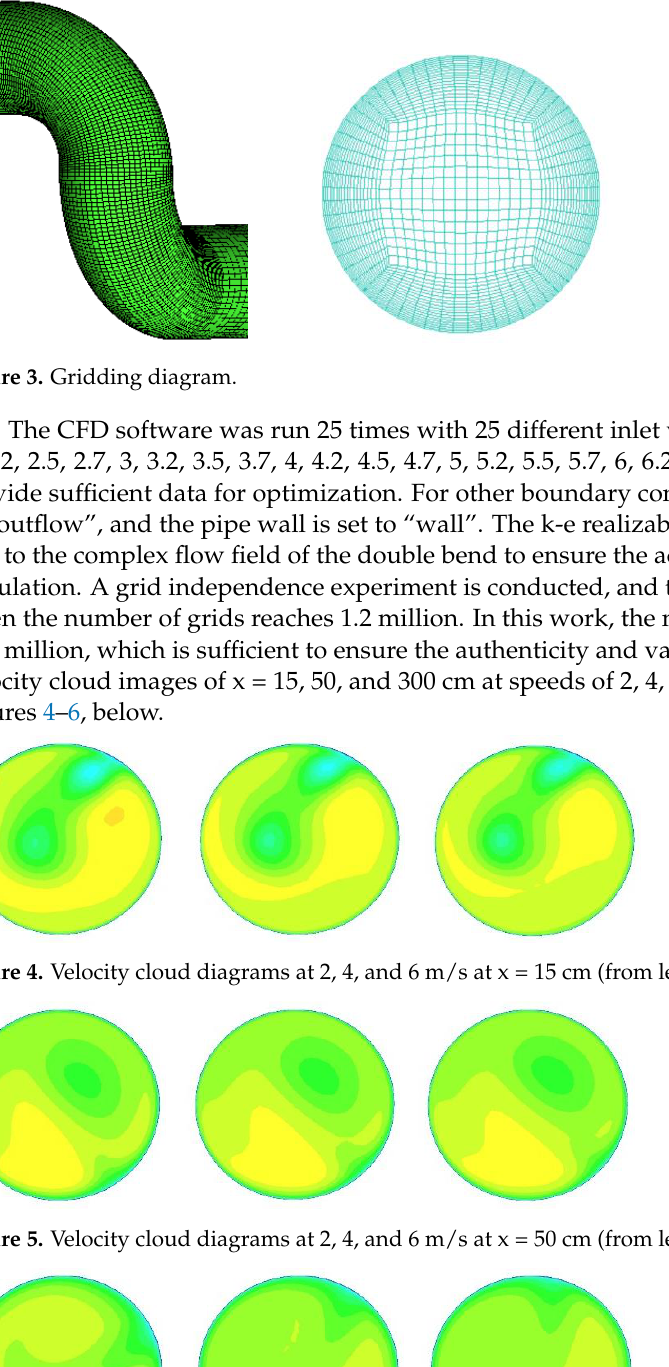
Figure 3. Gridding diagram.